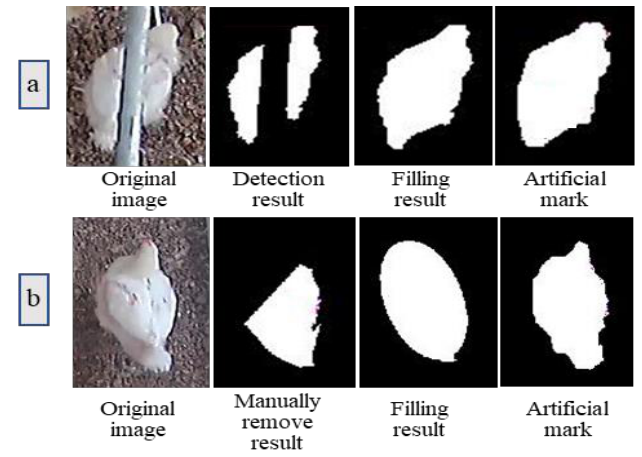
Figure 9. Comparison between restored chicken image area and an intact chicken image area (without occlusion): ( a ) process of image restoration for the TA situation; and ( b ) an intact chicken image without occlusion but artificially edited as the OA situation by removing a part for method evaluation. Table 2. Comparison of average values on different